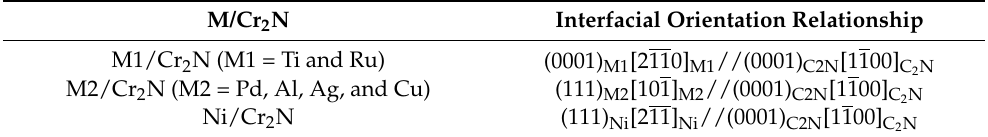
Figure 3. Interface models of M/Cr 2 N interfaces, including ( a – e ) M1(0001)/Cr 2 N(0001) (M1 = Ti and Ru), ( f – j ) M2(111)/Cr 2 N(0001) (M2 = Pd, Al, Ag, and Cu), and ( k – o ) Ni(111)/Cr 2 N(0001). The orientation relationships of the interface models are (0001) M1 [2 1̅1̅ 0] M1 //(0001) C2N [1 1̅ 00] C2N , (111) M2 [10 1̅ ] M2 //(0001) C2N [1 1̅ 00] C2N , and (111) Ni [2 1̅1̅ ] Ni //(0001) C2N [1 1̅ 00] C2N , respectively. There are five atom layers in the top views of ( a 1 – e 1 ), ( f 1 – j 1 ) and ( k 1 – o 1 ). The smallest spheres denote interfacial atoms of metal phases, from the second smallest to largest spheres are atoms from the first to fourth layers of Cr 2 N(0001). Five interface models for each M/Cr 2 N are considered: ( a 1 , f 1 , k 1 ) 1N-T top, ( b 1 , g 1 , l 1 ) 1N-T hollow, ( c 1 , h 1 , m 1 ) 2N-T top, ( d 1 , i 1 , n 1 ) 2N-T hollow, and ( e 1 , j 1 , o 1 ) Cr-T. Table 4. The interface orientations of M1/Cr 2 N (M1 = Ti and Ru), M2/Cr 2 N (M2 = Pd, Al, Ag, and Cu), and Ni/Cr 2 N interface models.